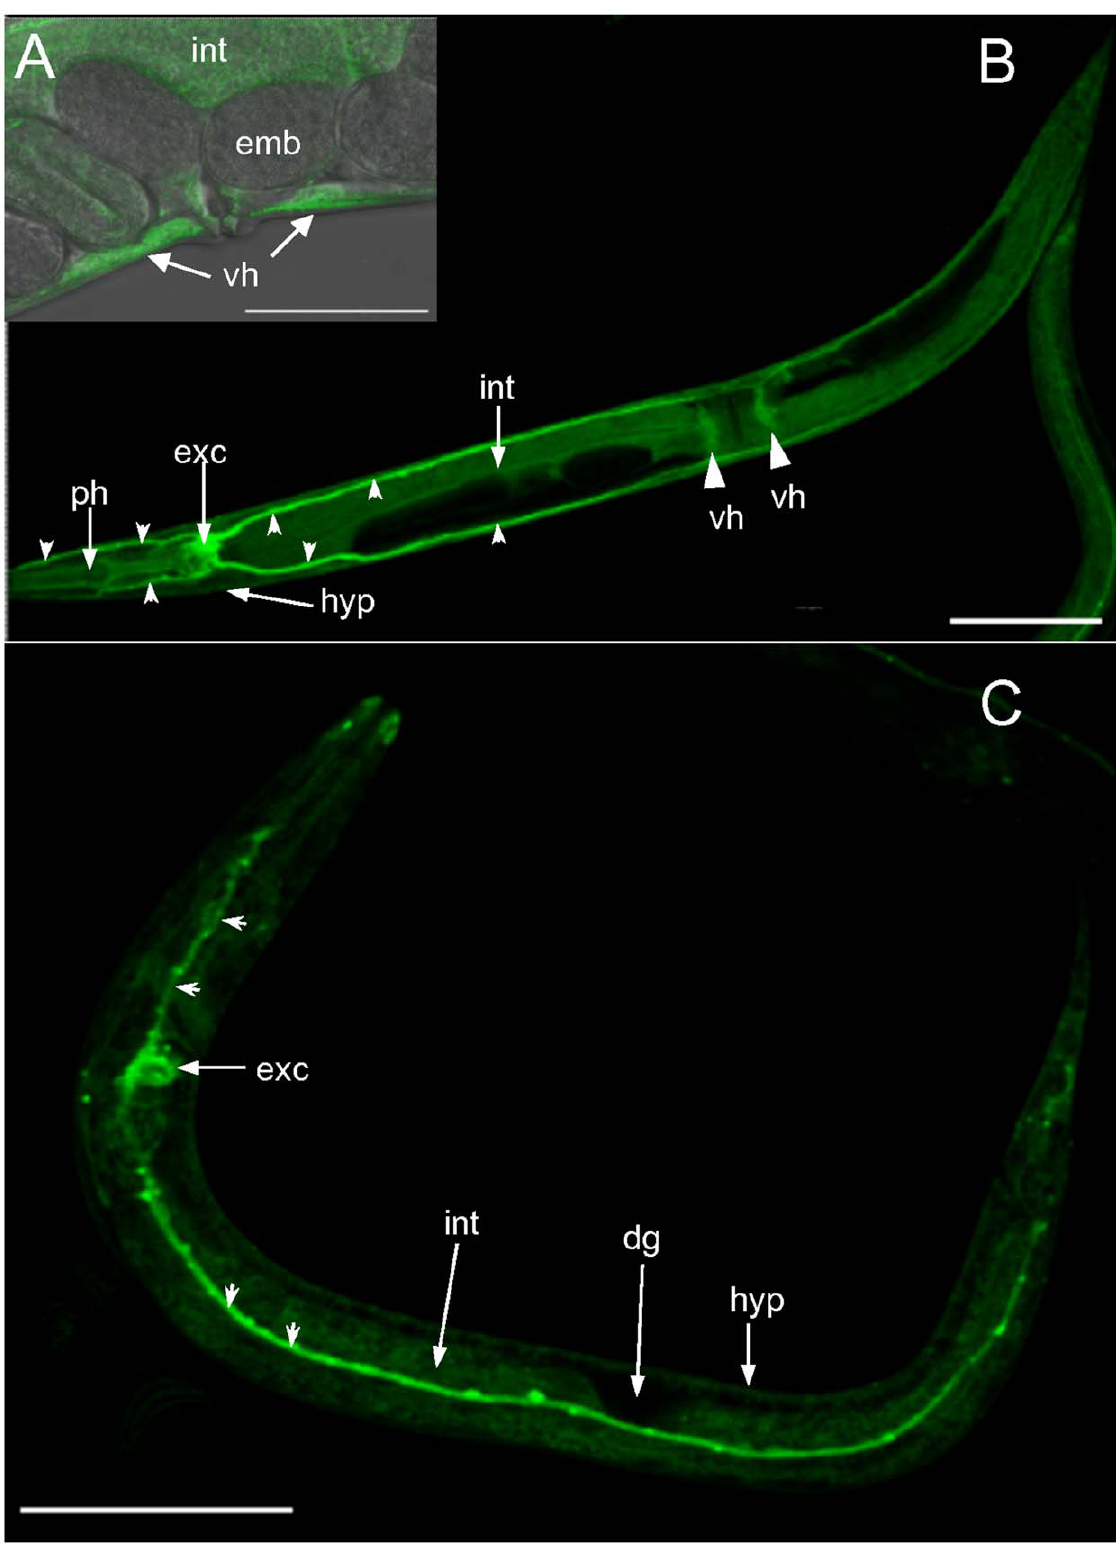
Figure 5. Expression of GFP directed by the presumed vha-19 promoter in transgenic vha-19p::GFP C.elegans . A) High magnification of the vulva region of adult vha-19p::GFP C. elegans [WT029] showing that vha-19 is expressed in vulval hypodermis (vh) and the intestine (int) but apparently not in early embryos (emb). The image is an overlay of a bright field and fluorescence image. B) An adult vha-19p::GFP C. elegans showing that vha-19 is expressed in the pharynx (ph), hypodermis (hyp), intestine (int), vulval hypodermis (vh) and excretory cell, consisting of the excretory cell body (exc) and the long, thin parallel canals either side of the cell body (indicated by small arrow heads). C) Fluorescence image of a vha-19p::GFP